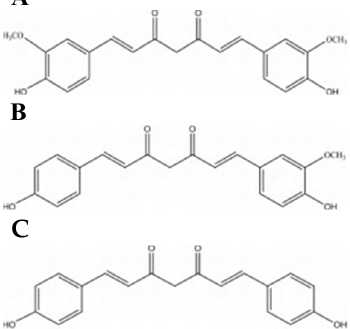
Figure 1. The molecular formulas of CUR and its compounds [40]. ( A ) The chemical structure of CUR. ( B ) The chemical structure of DMC. ( C ) The chemical structure of BMC.